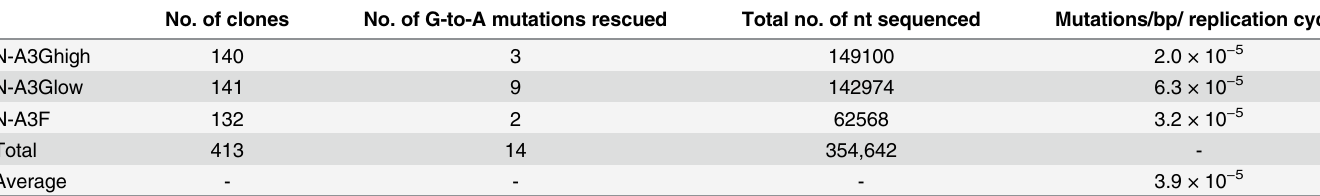
Table 3. Contribution of hypermutation to the HIV-1 mutation rate per replication cycle. No. of